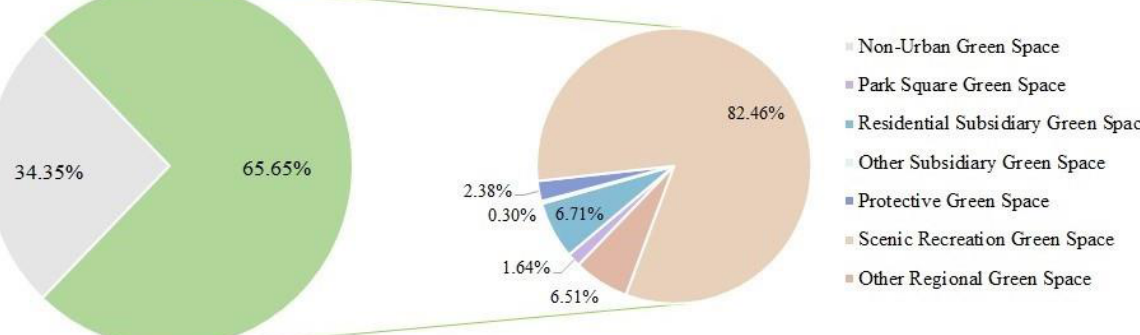
Figure 6. Proportion of UGS and proportion of functional UGS in study area.